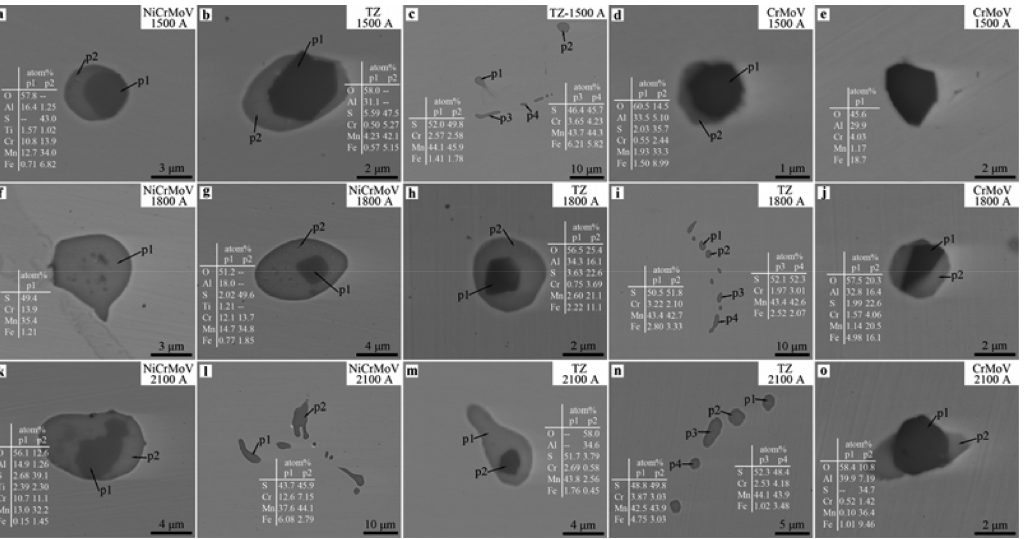
Figure 6: SEM images of typical inclusions observed in ESR dual alloy ingot: (a-e) specimen 1500 A, (f-j) specimen 1800A, (k-o) specimen 2100 A.